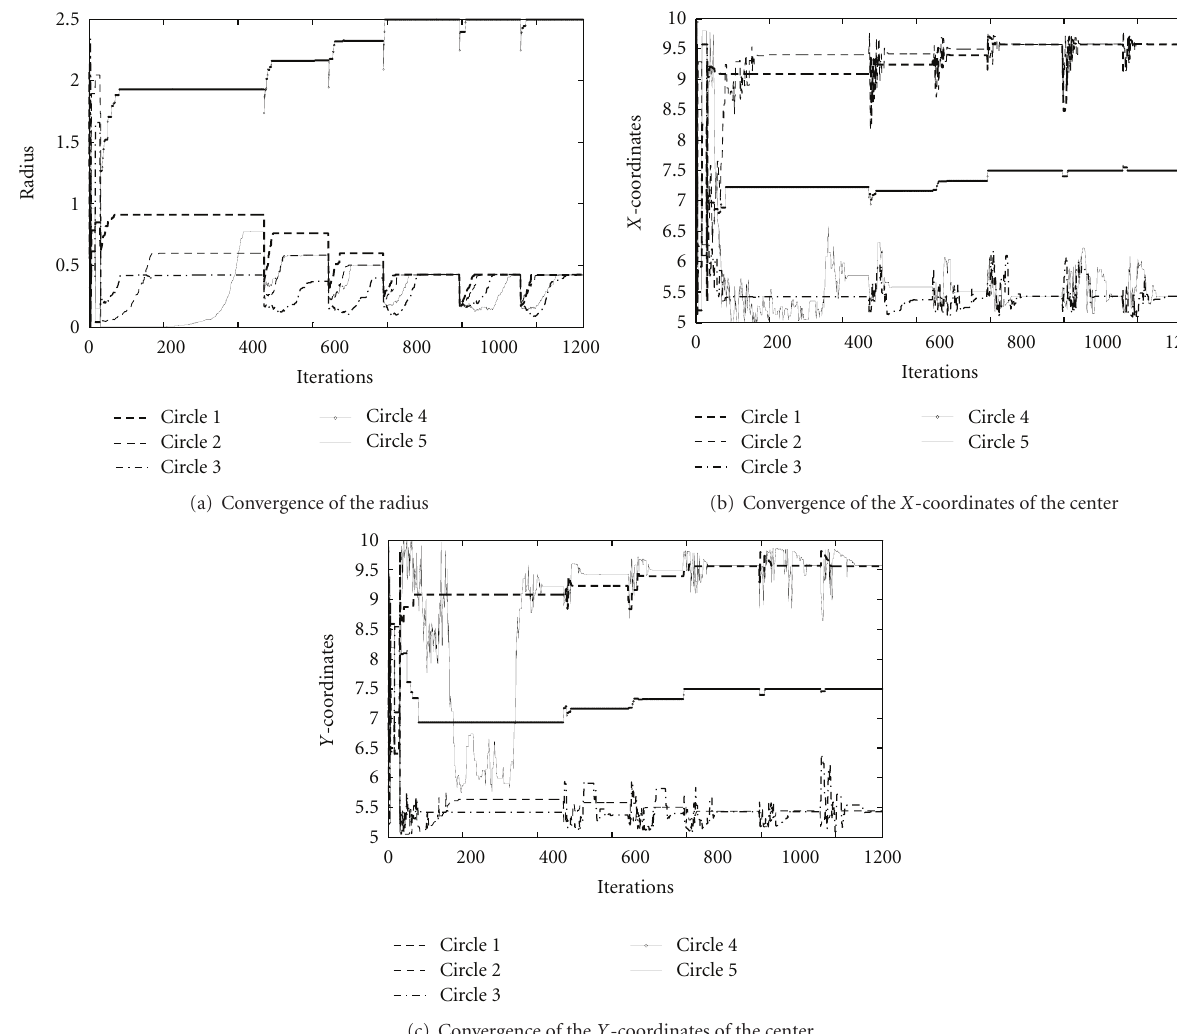
Figure 8: Convergence of the strategies of circle